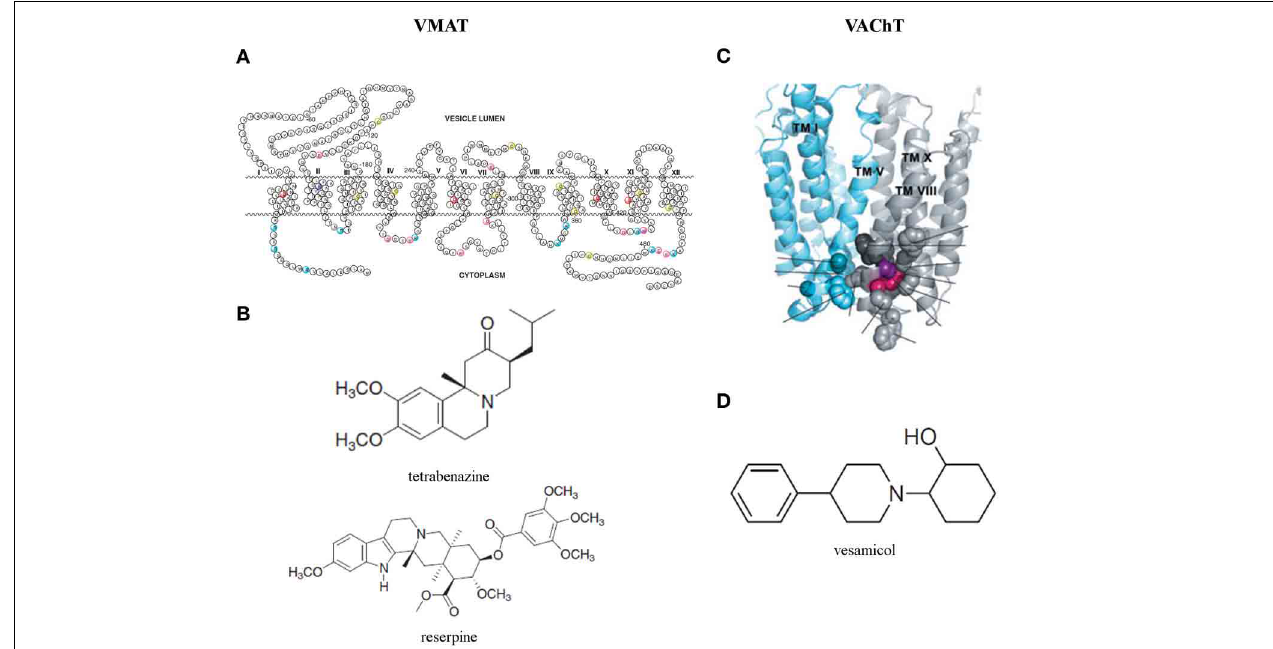
FIGURE 4 | (A) Predicted secondary structure of the human vesicular monoamine transporter 2 (VMAT2) and (B) two classical and now commonly used VMAT inhibitors: tetrabenazine and reserpine (Wimalasena, 2010). (C)